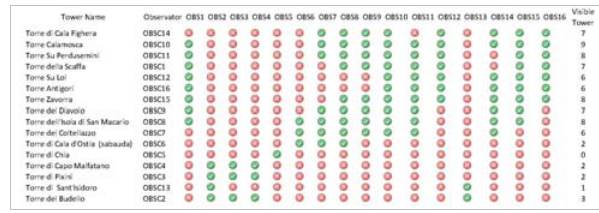
Figure 11: An example of data sheet summarizing the visibility study for a block of sixteen towers.